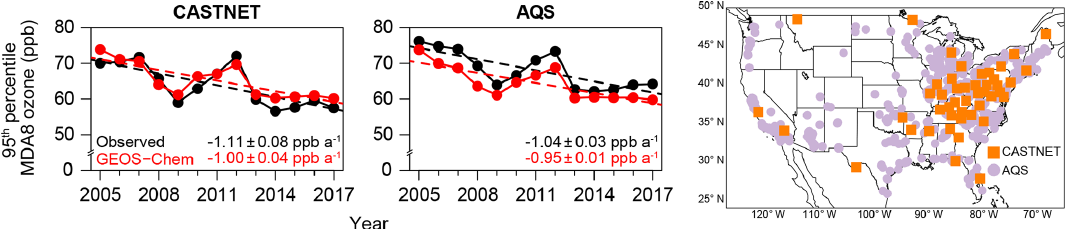
Figure 3. Summertime surface ozone trends for 2005–2017 at the CASTNET and AQS networks in the contiguous US. The trends are for the 95th percentile of the maximum daily 8h average (MDA8) ozone concentrations computed for individual sites (shown in the map on the right) and then averaged over all sites from the network. High-elevation ( > 1 . 5km) CASTNET sites in the western US are excluded. The slope and standard deviation of the linear regressions are shown inset, and all trends shown are statistically significant.